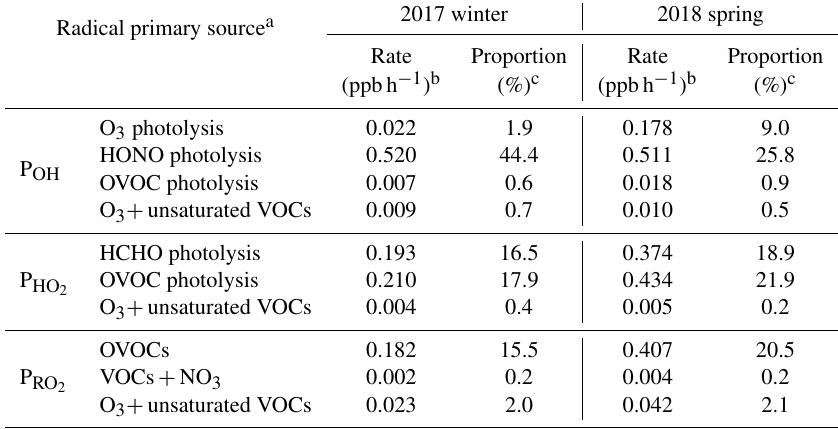
Figure 6. Scatterplots of the additional daytime HONO source strength (P other ) with NO 2 , NO 2 × ( S/V ) a , and J NO winter (a, b, c) and spring (d, e, f) . Table 3. Summary of major primary sources of OH, HO 2 , and RO 2 radicals simulated by the MCM model. Radical primary source